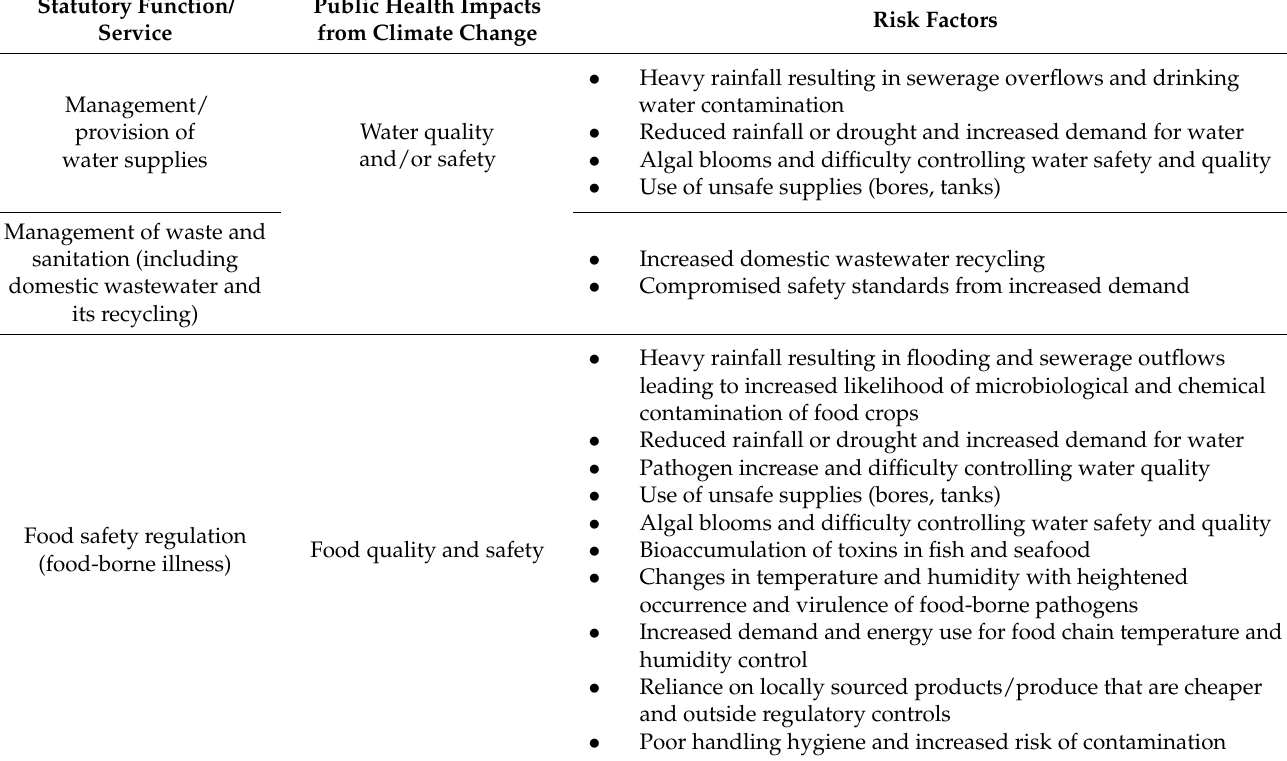
Table 2. Local health protection statutory functions and related climate change impacts and risk factors. (Adapted from